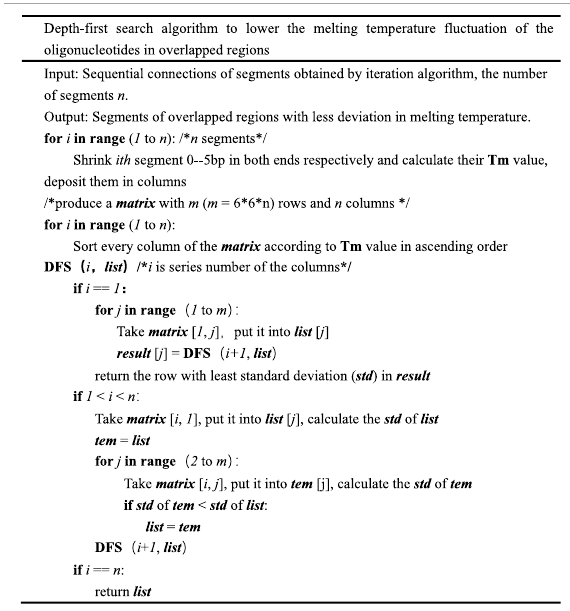
TABLE 2 Depth- fi rst search algorithm (DFS).